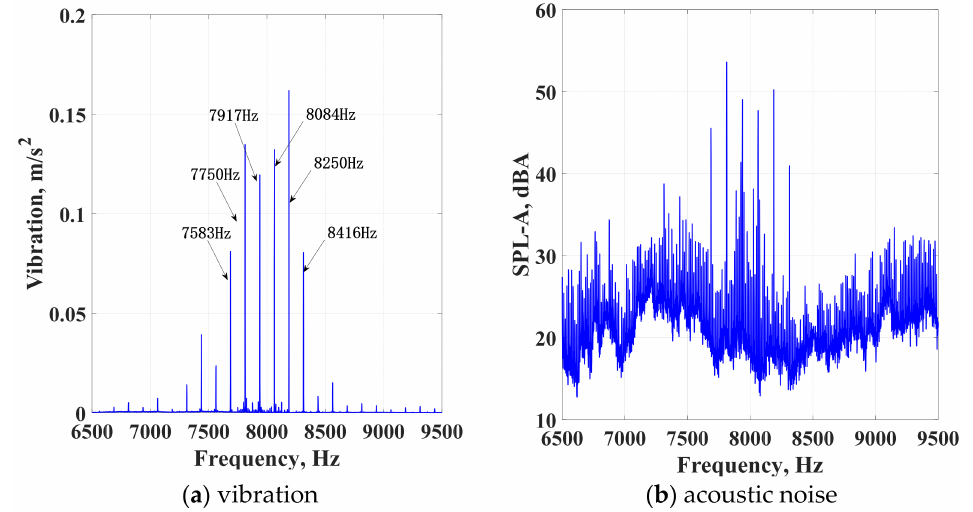
Figure 10. The sideband vibro-acoustic responses with the conventional